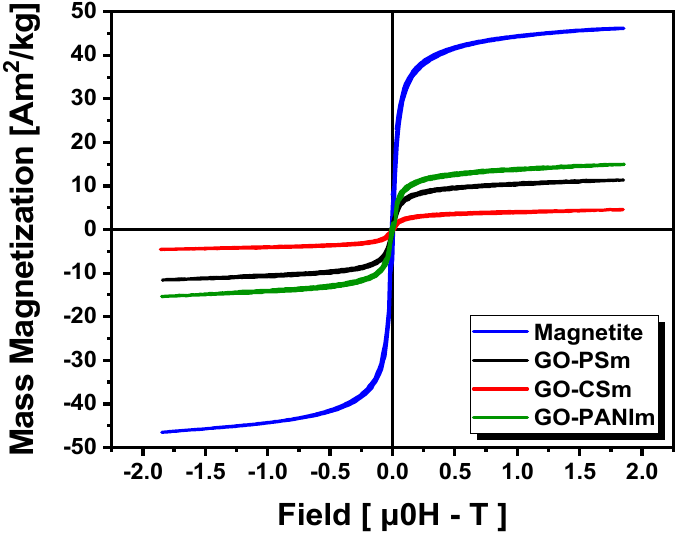
Figure 4. Magnetization curves for the magnetic composites; a pure magnetite loop is included for reference.